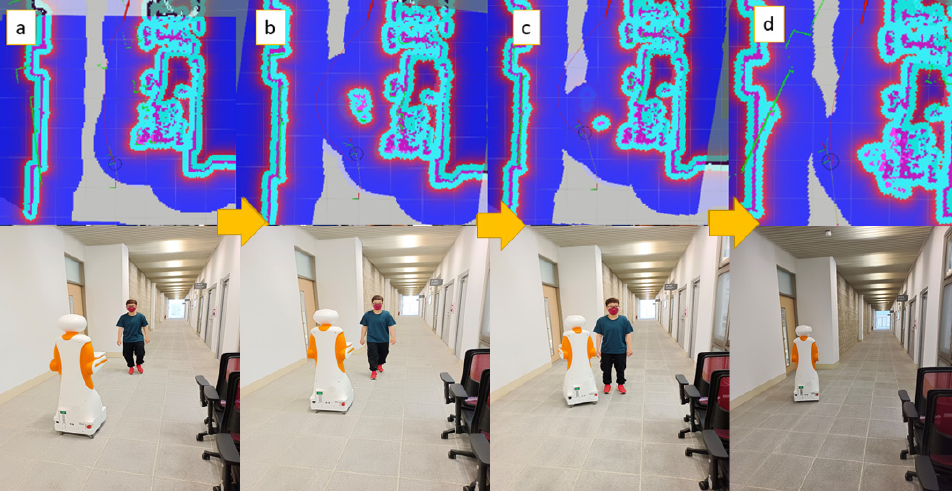
Figure 18. The subfigures ( a – d ) illustrate the obstacle avoidance process of the actual robot without the velocity obstacle layer. the velocity obstacle